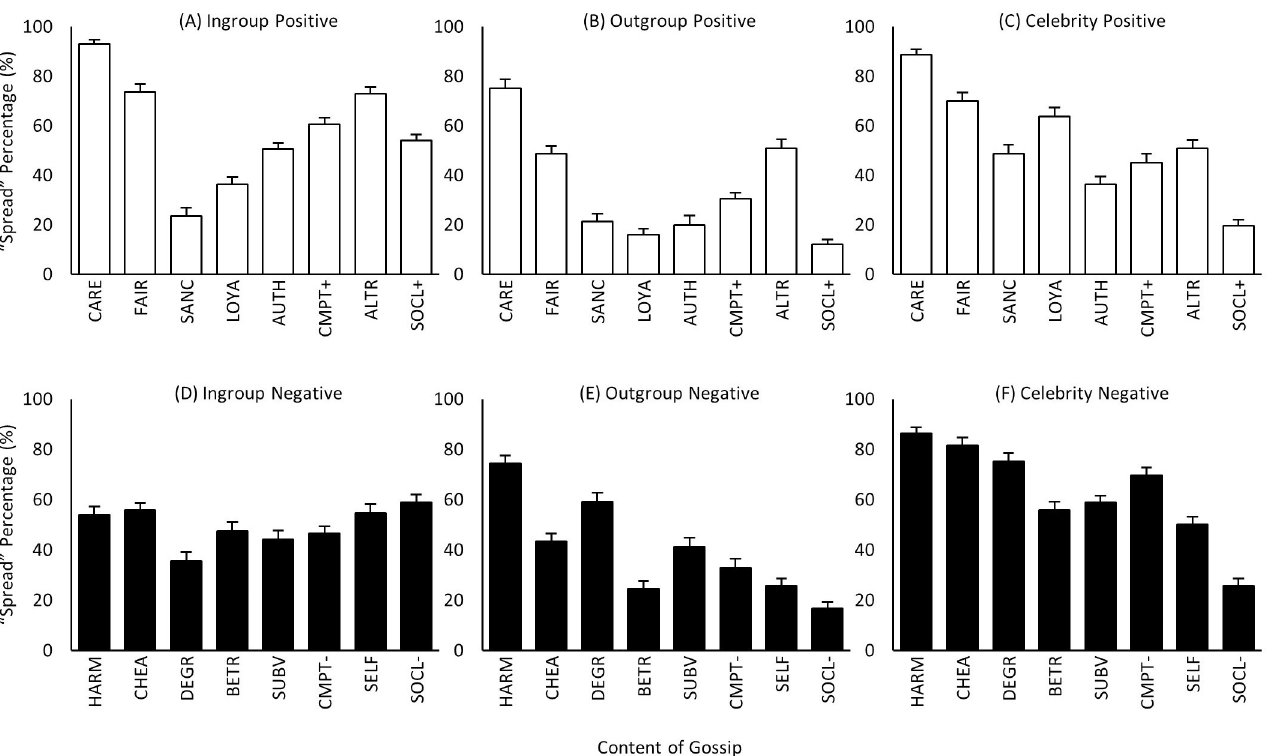
Fig 9. Mean gossip spread rates of 3-way interaction ‘content x valence x target’. (A)-(C) Mean spread rates of content domains for positive gossip of ingroup, outgroup, and celebrity targets, respectively. (D)-(F) Mean spread rates of content domains for negative gossip of ingroup, outgroup, and celebrity targets, respectively. (CARE: care, FAIR: fairness, SANC: sanctity, LOYA: group loyalty, AUTH: authority, CMPT+: positive competition, ALTR: altruism, SOCL+: positive general social affairs for positive, and HARM: harm, CHEA: cheating, DEGR: degradation, BETR: betrayal, SUBV: subversion, CMPT-: negative competition, SELF: selfishness, SOCL-: negative general social affairs for negative counterparts of 8 contents.) See S3 Table in S1 Text for statistical significance.